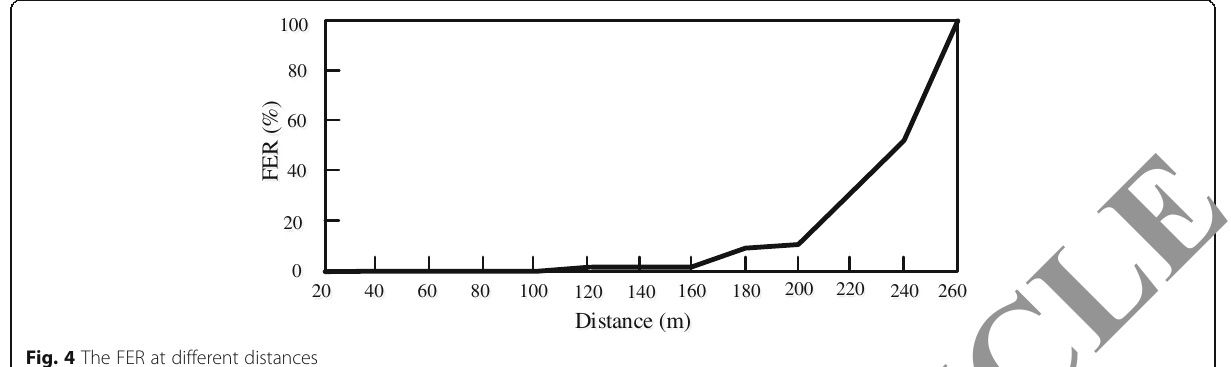
Fig. 4 The FER at different distances